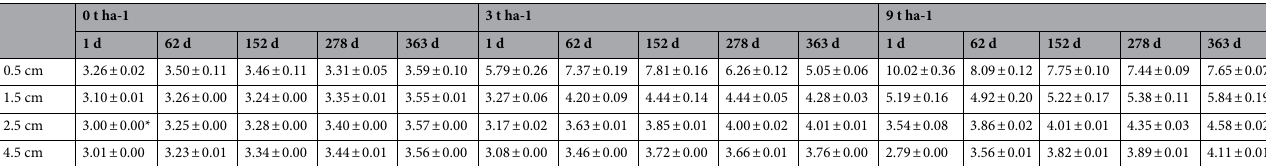
Table 1. Average pH values in the different soil depths corresponding to the soil samples used for sequencing of the prokaryotic community across wood ash concentrations and time points (mean ± SE). The soil pH was measured using 500 µm steps down the soil profile (see “Methods” section) and the presented values are calculated as the average pH measured in the depth intervals of [0–0.95 cm cm], [1–1.95 cm], [2–2.95 cm] and [4–4.95 cm] each consisting of 20 pH measurements. The full picture of the measured pH across all depths and time points (monthly intervals) are found in Hansen et al 33 . *<